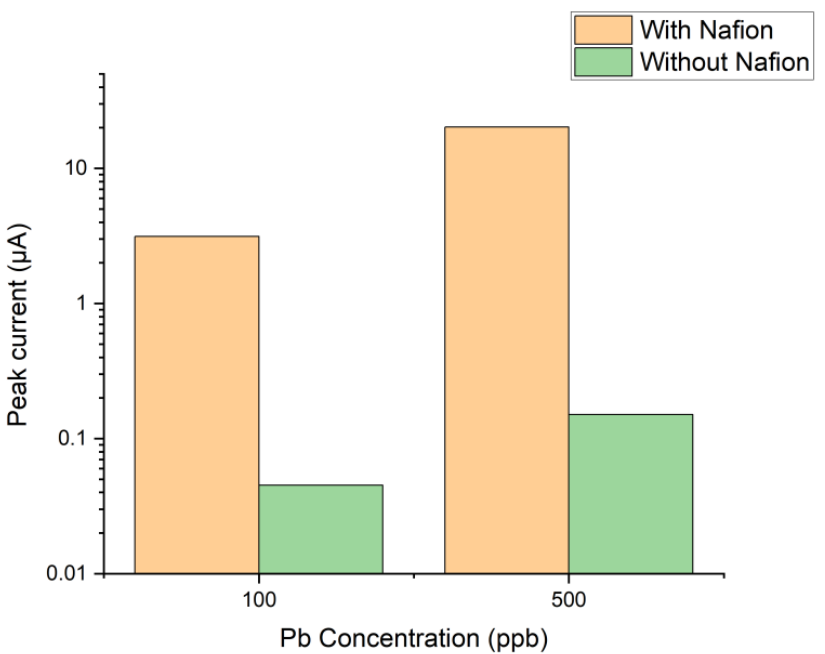
Figure 8. Peak current (log 10 scale) of ASWV for detection of different Pb(II) concentrations using sensors with or without a Nafion membrane.